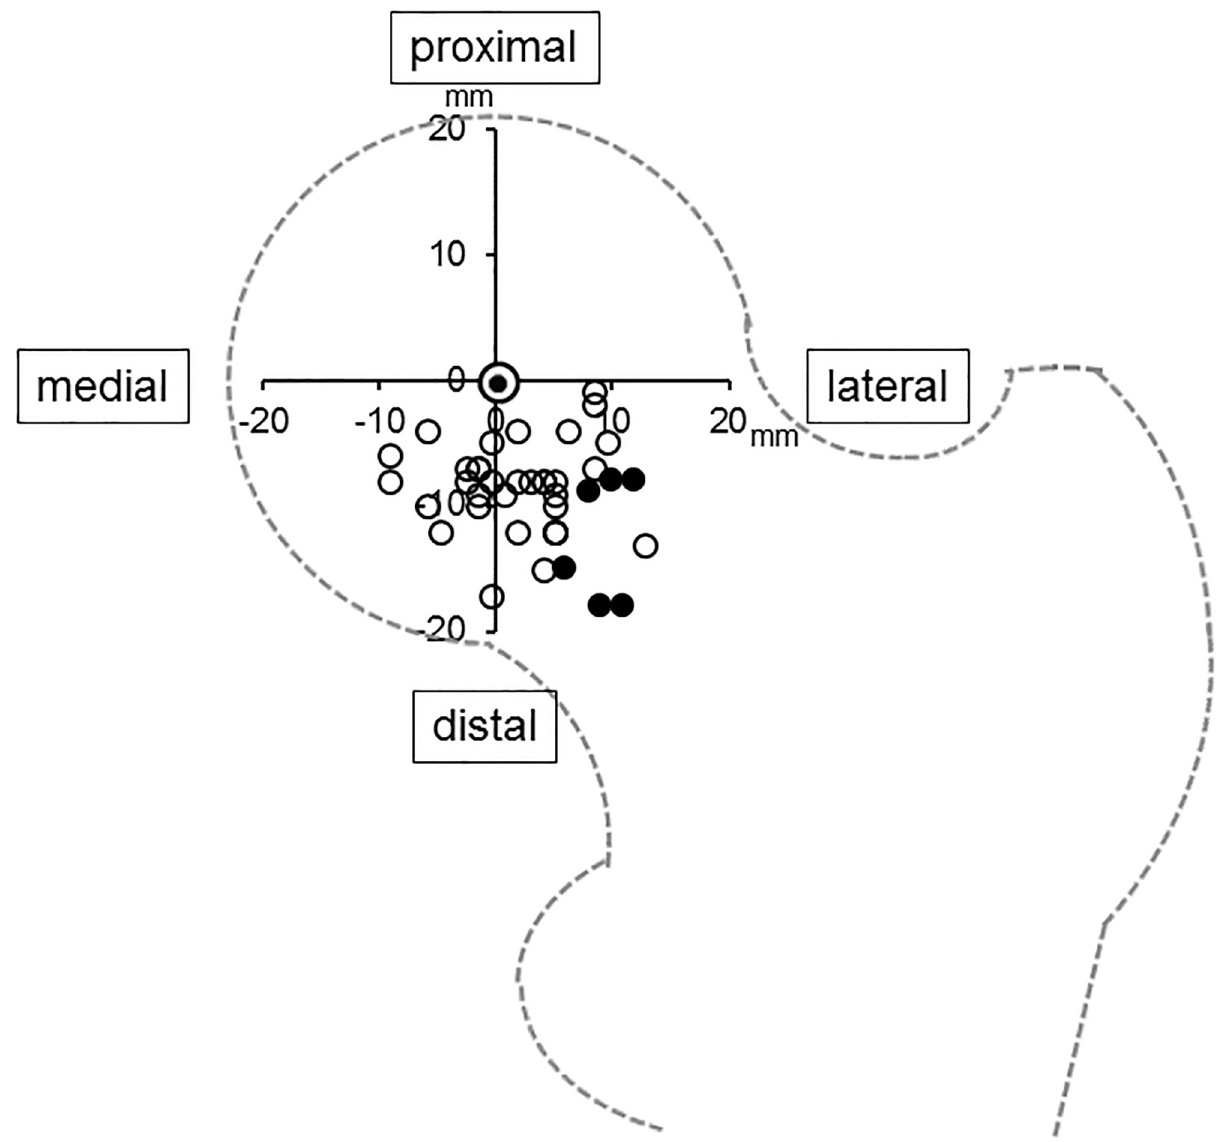
Fig 5. Scatter diagram for the distribution of the center of the osteotomy arc compared to the center of the femoral head. Double circle indicates the center of the femoral head. White circles indicate the centers of the osteotomy arc of cases with leg shortening < 5mm. Black circles indicate the centers of the osteotomy arc of cases with leg shortening �